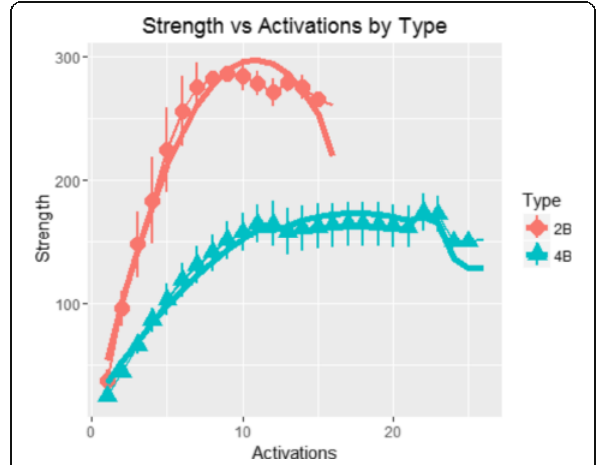
Fig. 8 Intercepts of the two- and four-arm